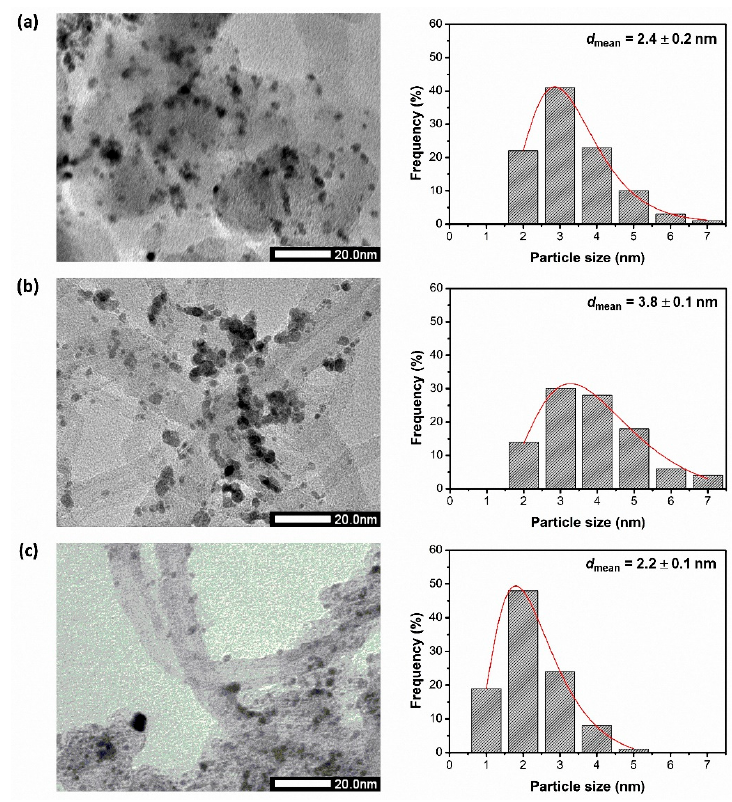
Figure 2. TEM images and particle size distributions of ( a ) PtRu/C, ( b ) PtRu/MWCNTs, and ( c ) PtRu/C 60 MWCNTs 40 . Table 2. Electrochemical parameters of PtRu/C, PtRu/MWCNTs, and PtRu/C 60 MWCNTs 40